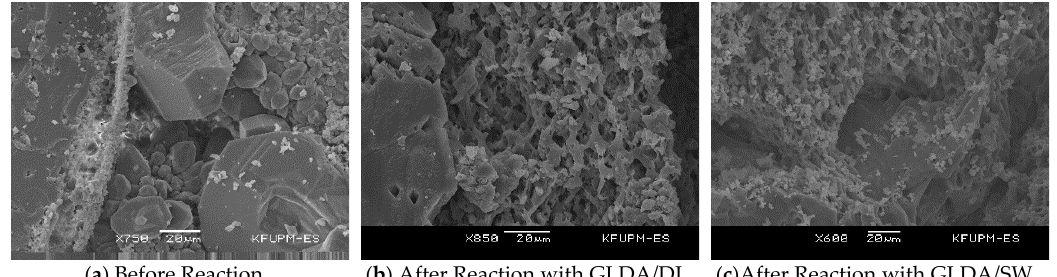
Figure 9. SEM surface morphology of Indiana limestone rock surface ( a ) before reaction; ( b ) after reaction with GLDA/DI; and ( c ) after reaction with GLDA/SW acid systems at 200 °F and 1000 RPM.